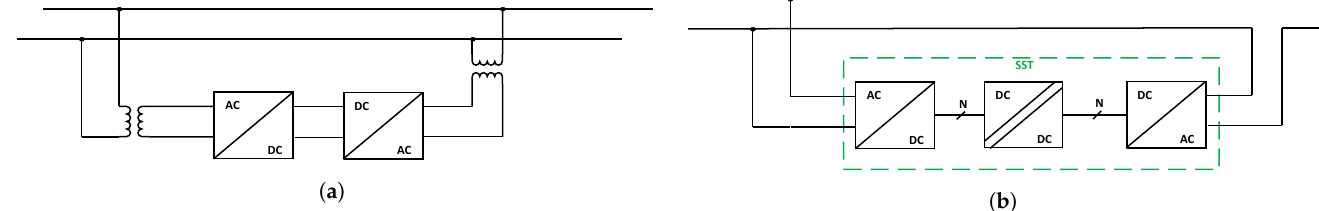
Figure 14. ( a ) Classical approach for a UPFC device. ( b ) The alternative SST